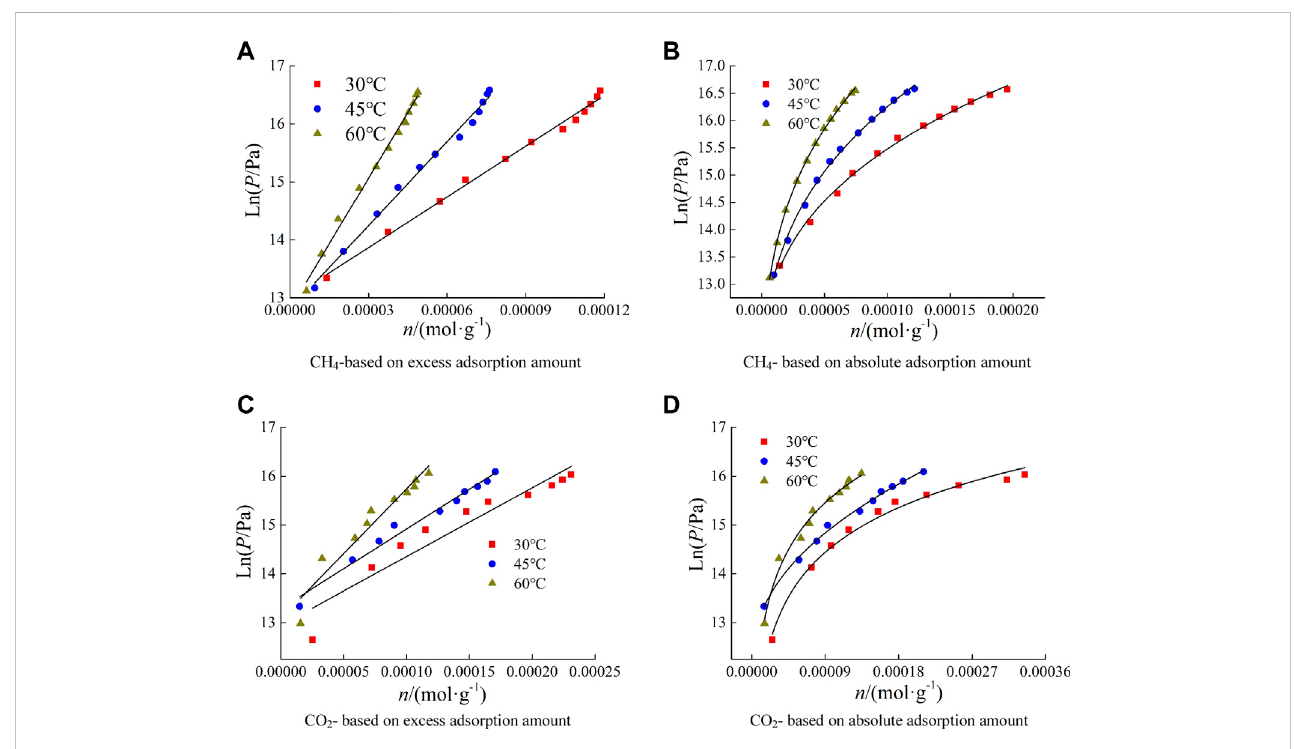
FIGURE 7 The fi tting curve of ln p-n under different types of adsorption